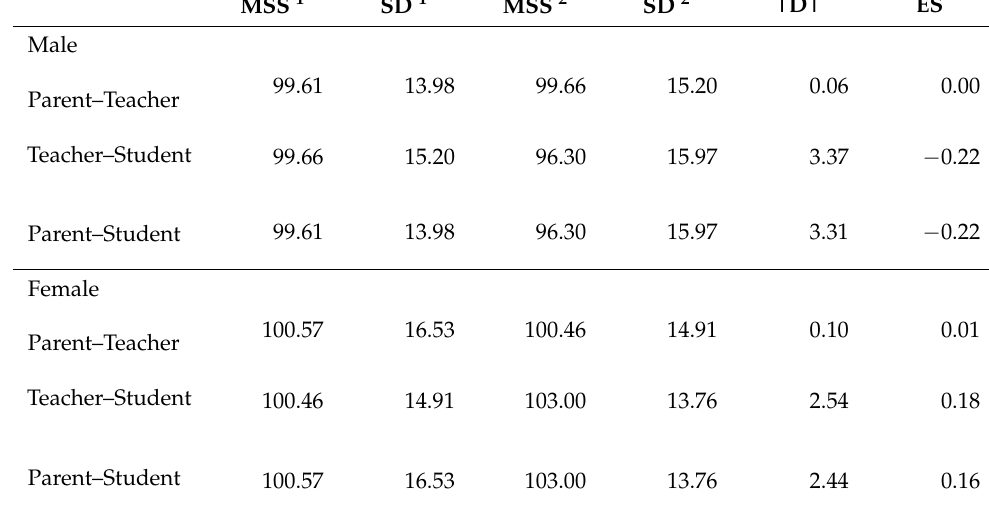
Table 5. Standardized mean difference effect size for different between-raters’ scores on Total Social Skills